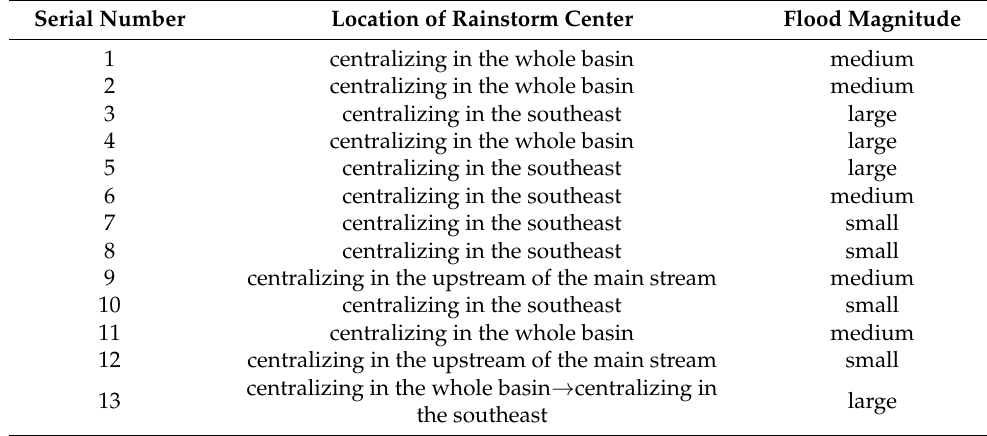
Table 1. The characteristics of typical floods.